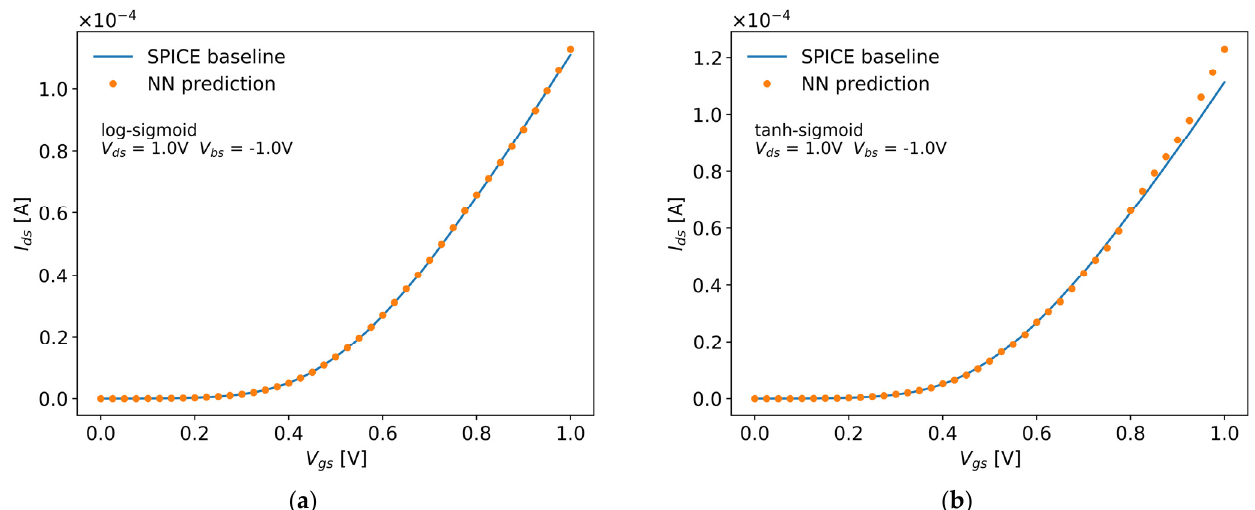
Figure 3. Transfer curves with different activation functions: ( a ) fitting curves of log-sigmoid; ( b ) fitting curves of tanh-sigmoid. Easy to see: In the small voltage range, both curves fit quite well. However, when using the tanh-sigmoid function, there are obvious errors in the higher-value range. Some criteria were used in this study to better estimate the trained NN models and avoid overfitting. Those criteria include the Akaike Information Criterion (AIC), the corrected Akaike Information Criterion ( AICc ), and the Bayesian Information Criterion ( BIC